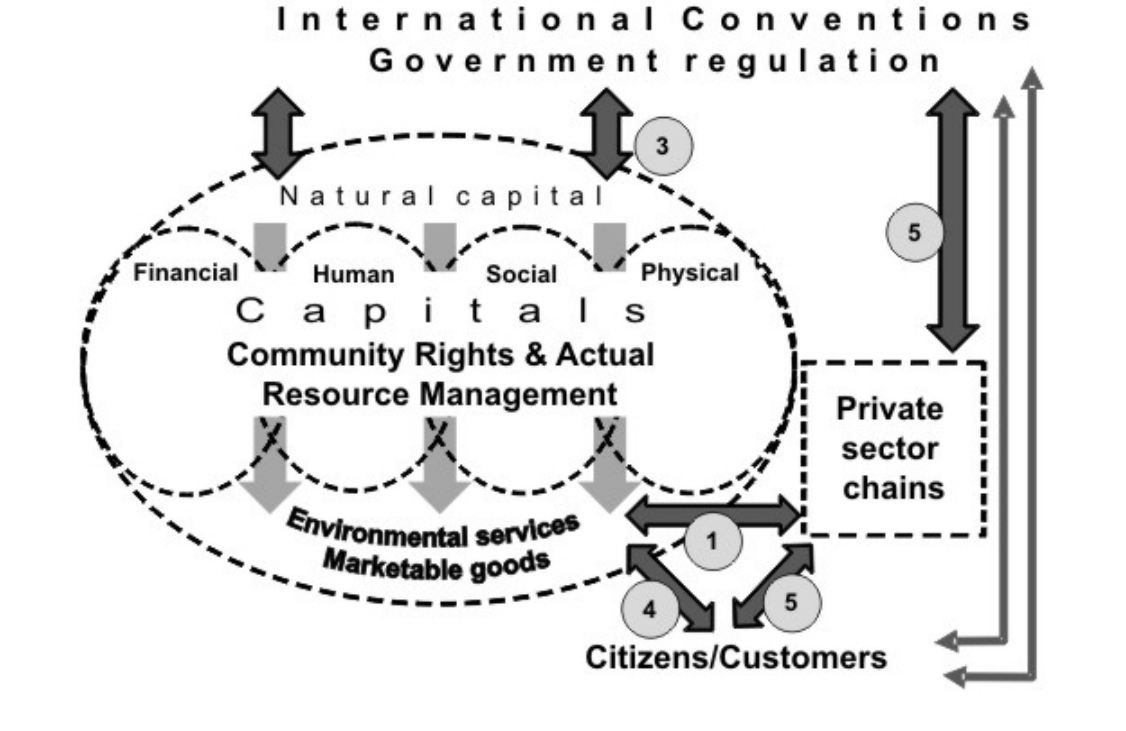
Fig. 2. Relationships between environmental goods and services provision, actors in the landscape, and five assets (capitals): natural (soil, land, and water), human (capacity to manage resources), social (healthy local institutions), physical (adequate access to public infrastructure), and financial (adequate money to invest).